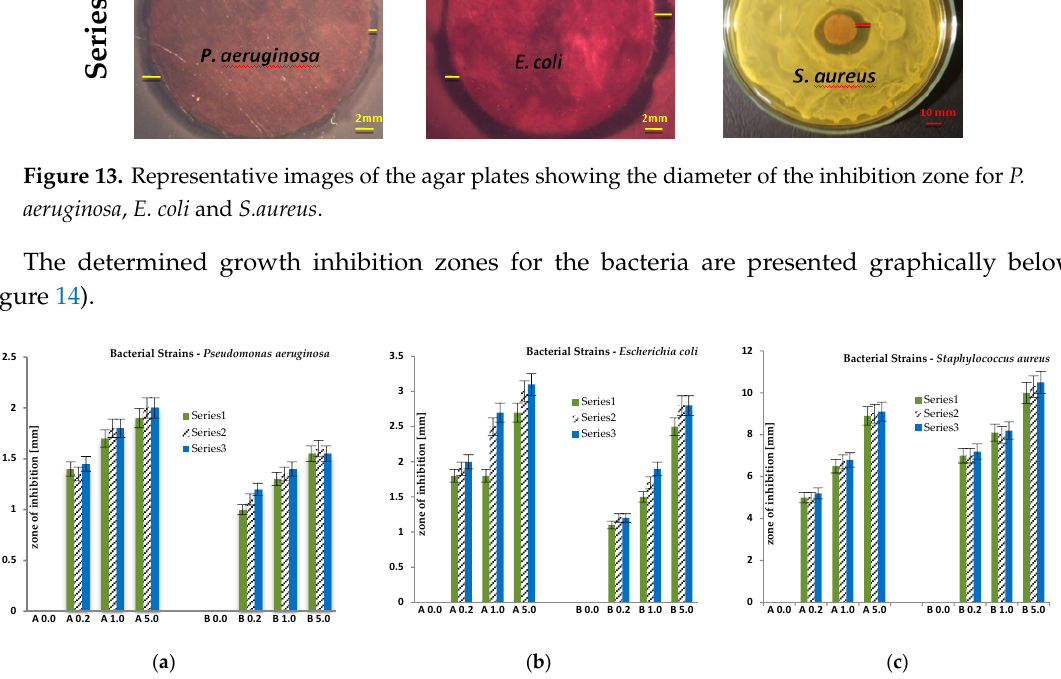
Table 6. Zone of inhibition for various sample treatments against Gram-negative Escherichia coli, Pseudomonas aeruginosa and Gram-positive Staphylococcus aureus from an average of three different experiments, with a standard deviation of ±0.1–0.5 mm.